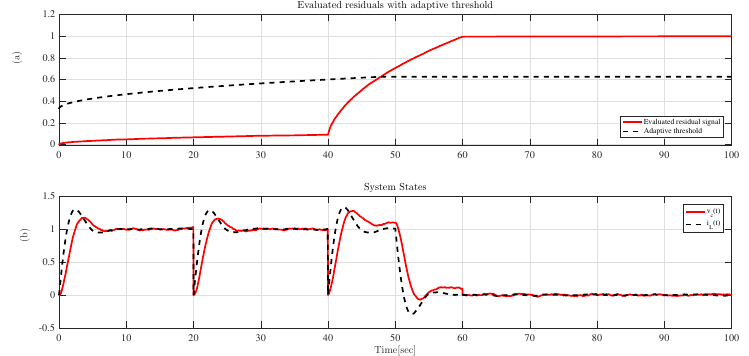
Figure 5. ( a ) Evaluated residual with adaptive threshold. ( b ) Switched system